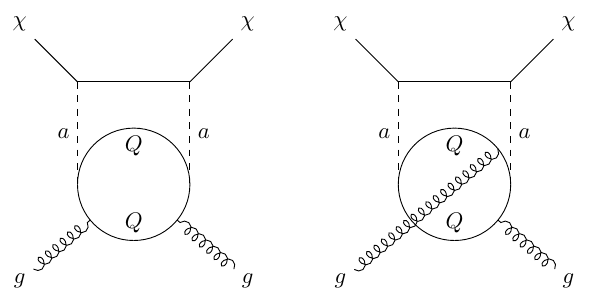
Figure 2 . Two-loop processes for the evaluation of the heavy quark ( Q = c; b; t ) contributions to e(cid:11)ective DM-gluon